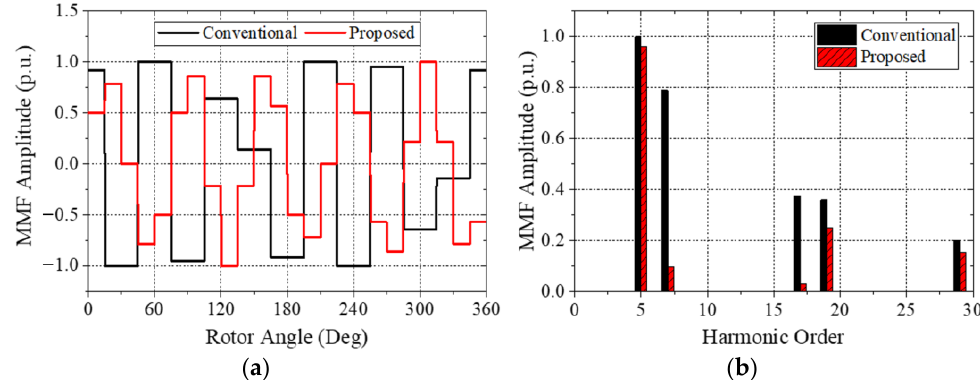
Figure 5. Total MMF distribution ( a ) profile and ( b ) harmonic spectrum of the conventional and proposed FSCW motor.